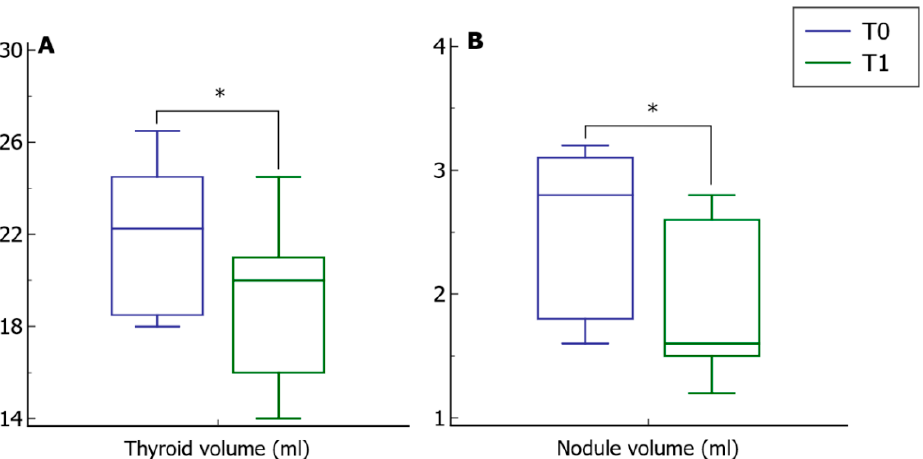
Figure 2. Thyroid and nodule volumes before and after treatment with metformin. Panels ( A , B ) show a significant reduction in the thyroid nodule volume following treatment with metformin, respectively. T0, values at baseline; T1, values after six months. * p <0.05.